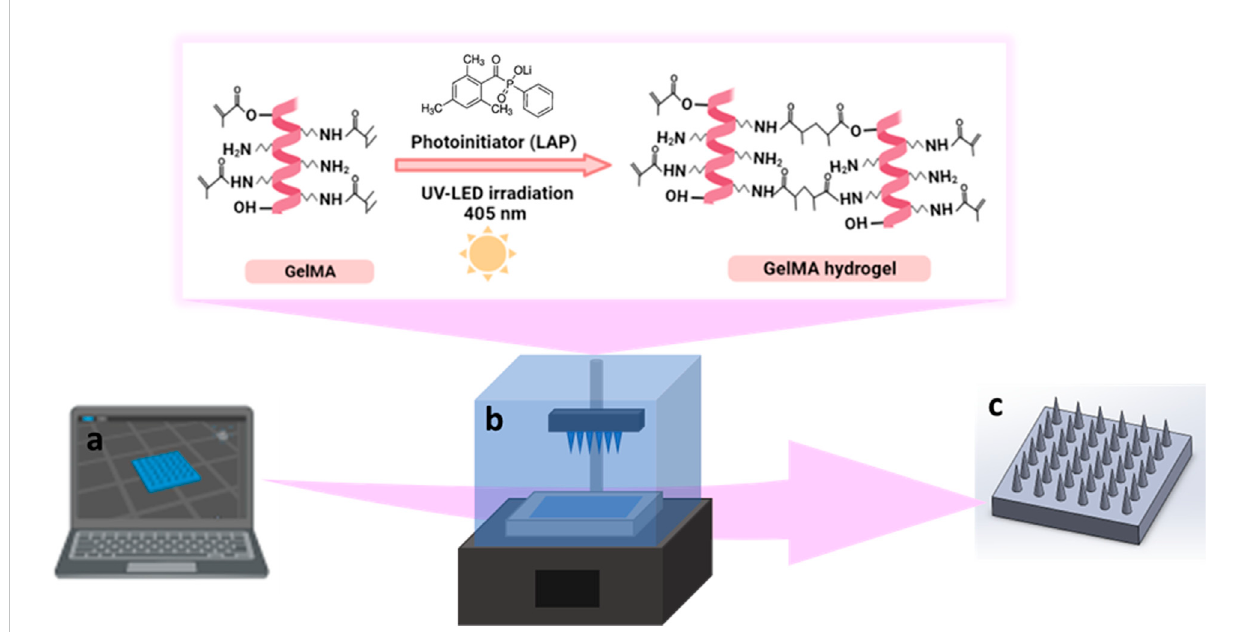
FIGURE 2 SchematicrepresentationofthedesignandfabricationofGelMAMNs, (A) designingofCADmodel, (B) photocrosslinking ofGelMAhydrogel during DLP printing, (C) 3D printed GelMA